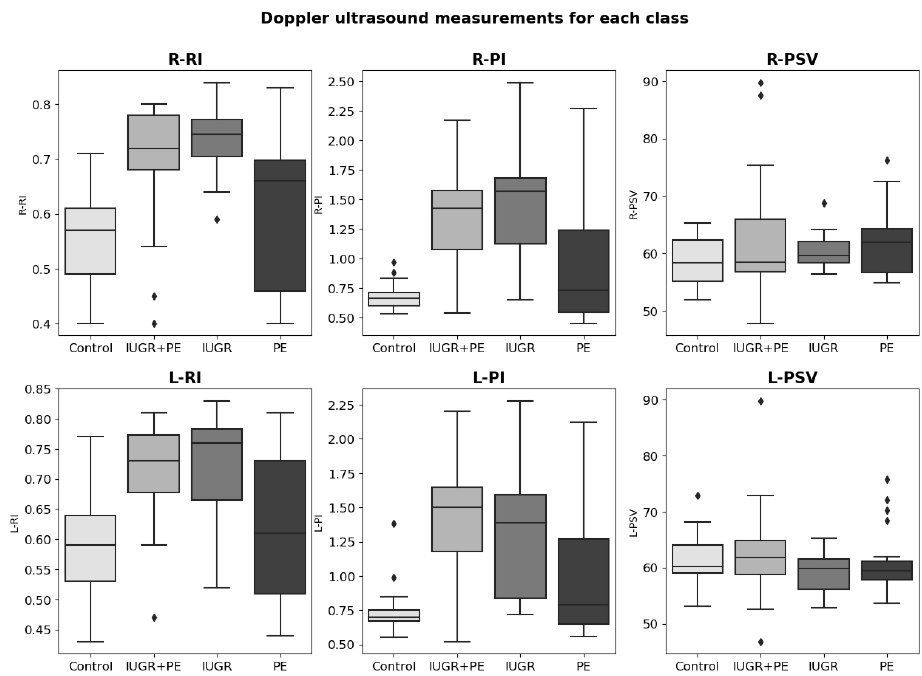
Figure 4. Distribution of UtAD measures for left (L) and right (R) uterine artery by class. The lozenge symbol “ (cid:169) ” represents the outliers values of each